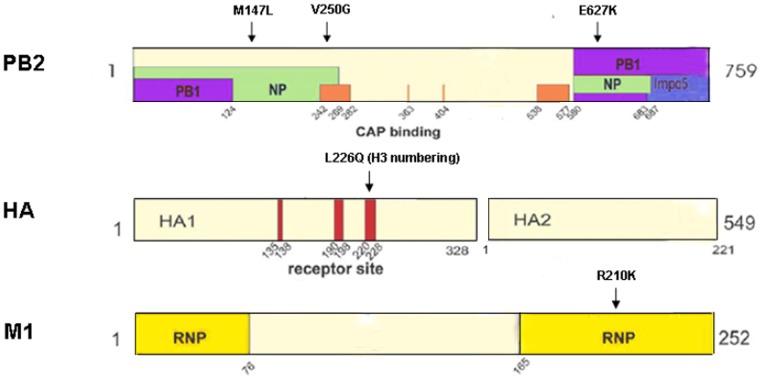
Amino acid differences between SD16 and SD16-MA.The amino acid location of mutations are numbered and indicated with arrowheads on the linear sequence. The locations of regions of protein binding, or functions are indicated with rectangles and are labeled with respect to interacting viral proteins. The PB1, NP and RNP ribonucleocapsid protein binding regions are in purple, green and yellow respectively; PB2 cap binding regions are in orange; HA receptor sites are in red.